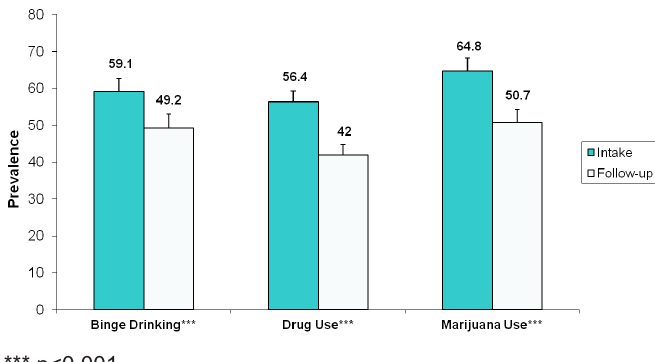
*** p<0.001 Figure 4. Changes in past 30 day prevalence of binge drinking, illicit drug use, and marijuana use among those at risk.